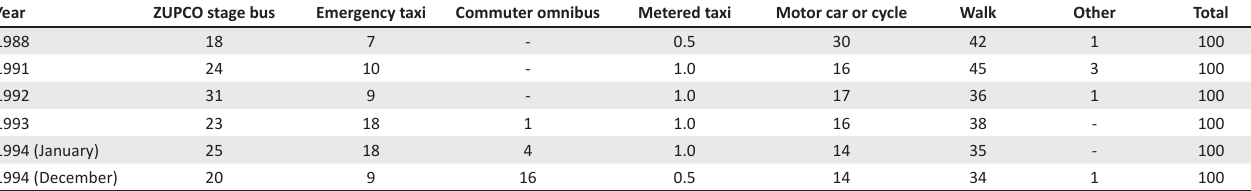
TABLE 2: Modal split throughout Harare (percentage).